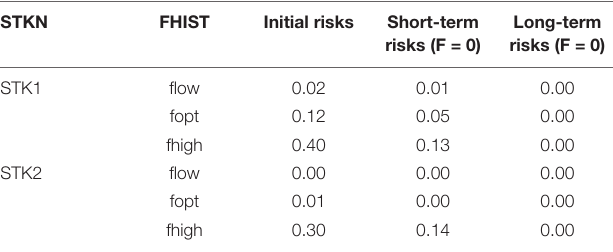
TABLE 2 | Biological risks for the different OM conditionings (combination of stock -STKN- and initial depletion level -FHIST-) for base case productivity and recruitment standard deviation at